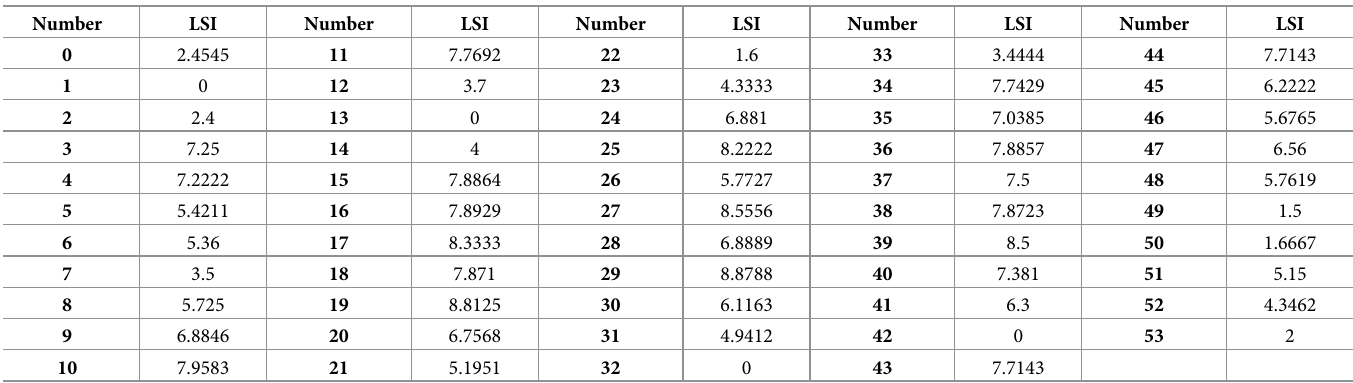
Table 5. LSI values of individual study